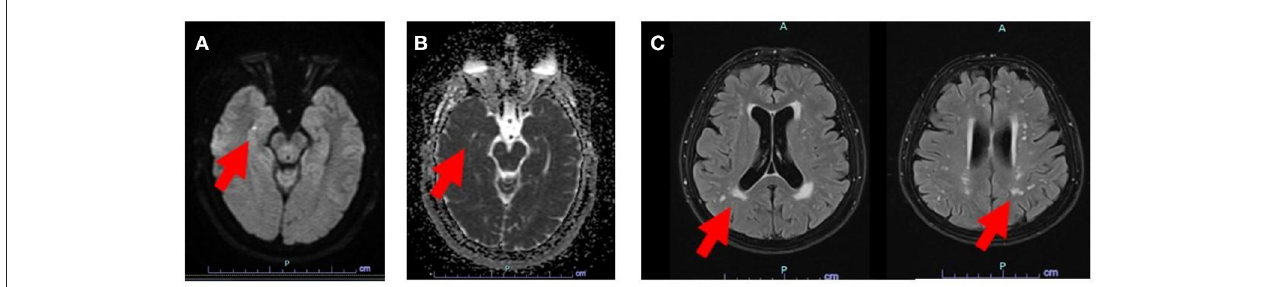
FIGURE 1 | MRI image showing DWI hyperintense lesion in the right hippocampus (A) , also seen by the corresponding ADC maps which display diffusion restriction (B) . Subcortical FLAIR lesions were also found in the same patient with a Fazekas score 2 (C) . Red arrows point to specific